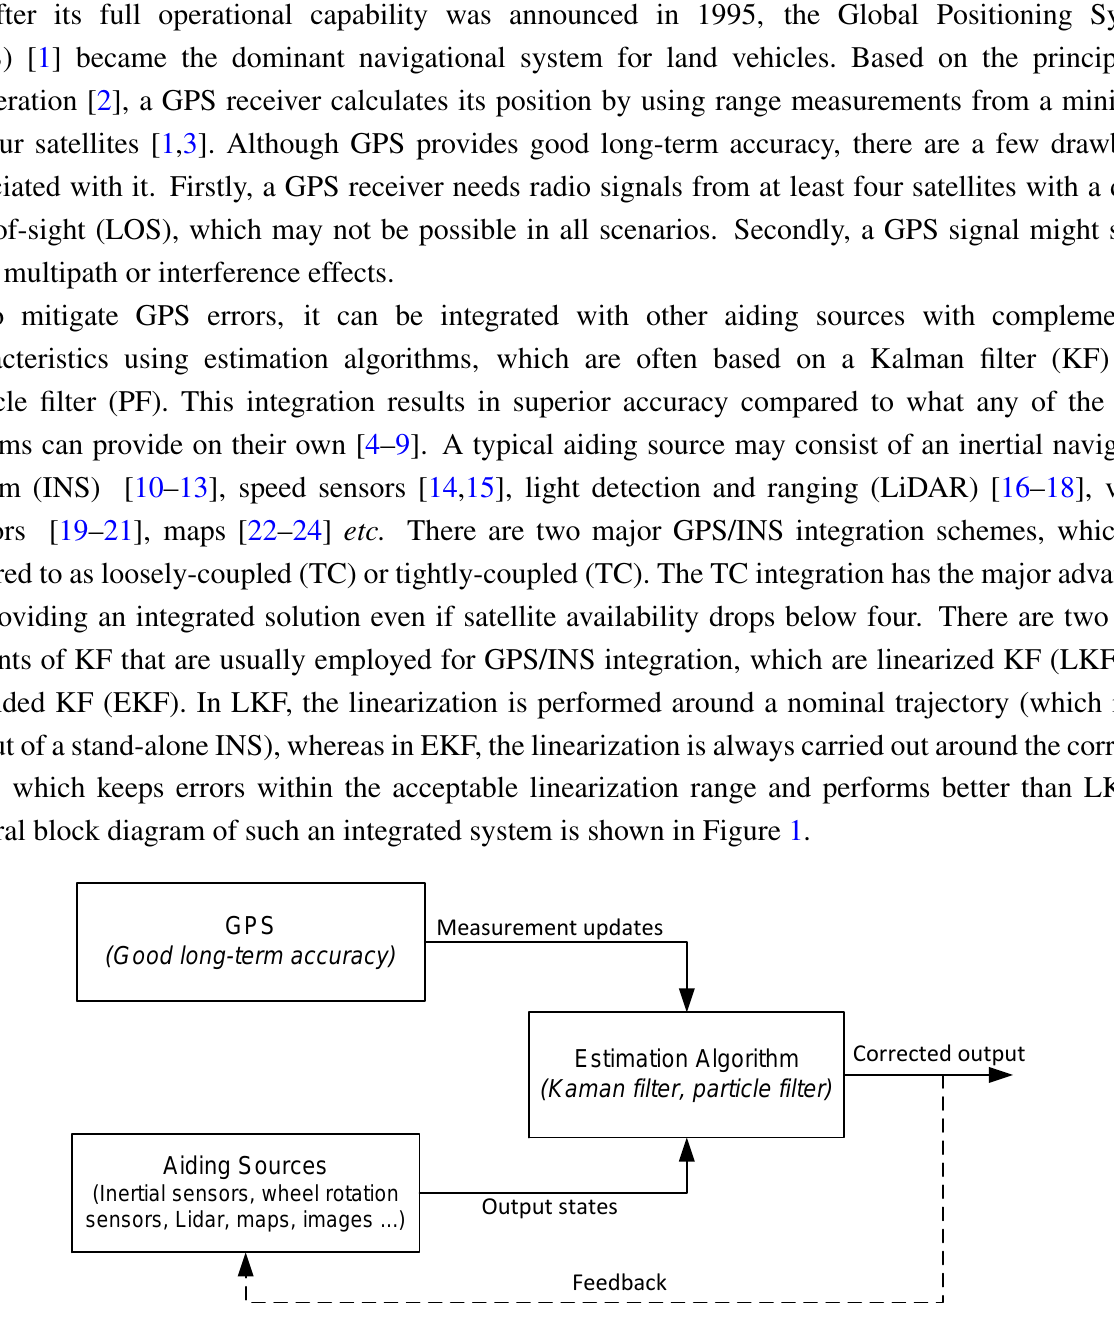
Figure 1. High level block diagram of system integration through estimation